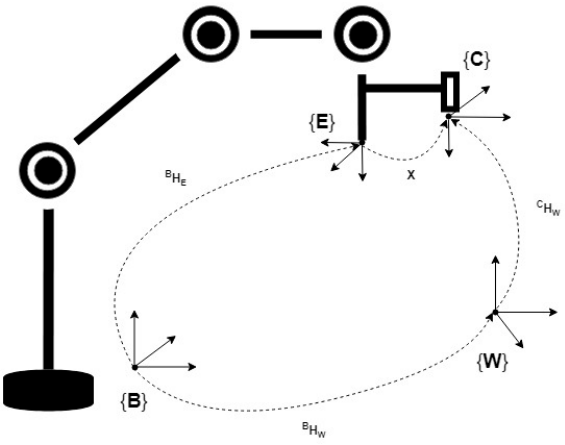
Figure 4. Coordinates for hand-eye calibration.